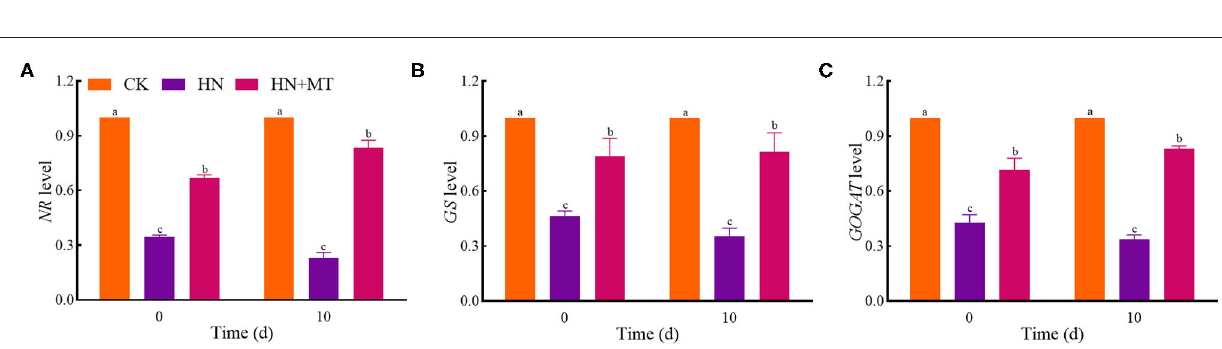
FIGURE 4 | Changes of NR (A) , GS (B) , GOGAT (C) , and GDH (D) . The groups on the same day followed with the same letter are not significantly different at p < 0.05. Bars indicate the SDs of the means.